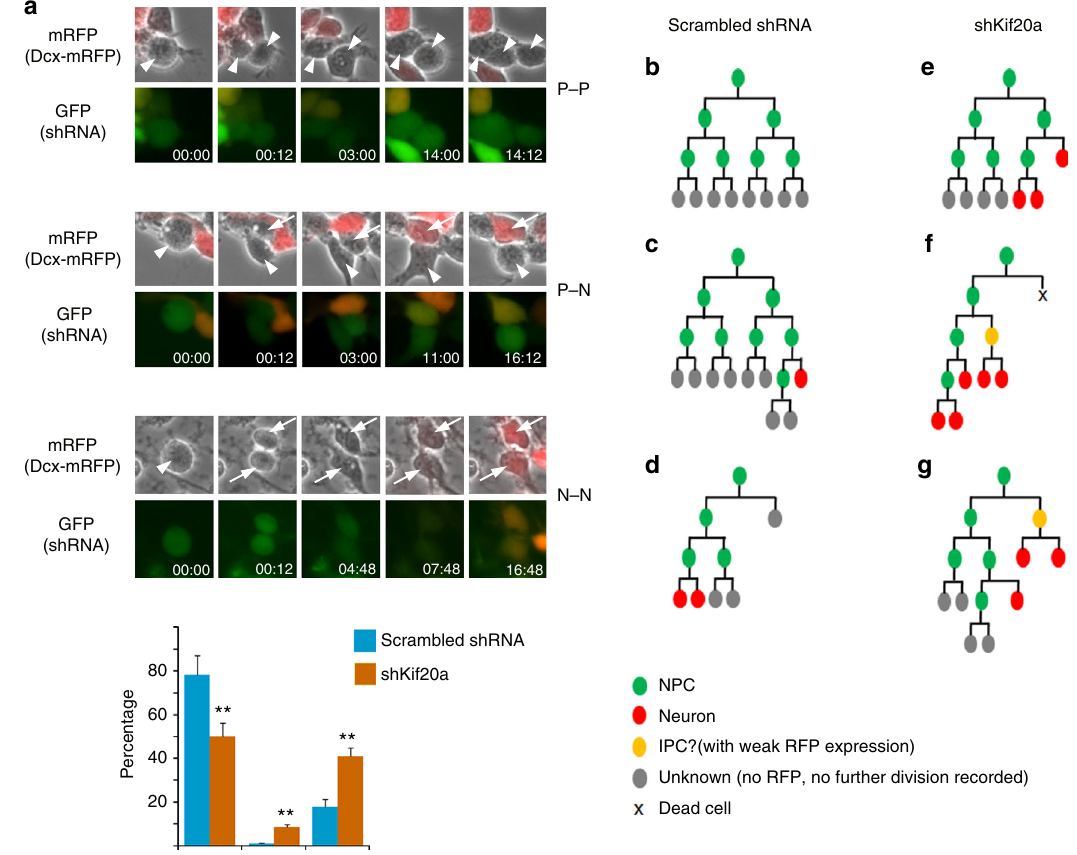
Fig. 3 KIF20A is important for the balance between proliferative and differentiative cell divisions. a Dissociated cells from the E13.5 cortices of the Dcx- mRFP transgenic reporter mice were infected with lentiviruses for expression of shKif20a or scrambled control shRNA. After culturing for 1 day post infection, shRNA-expressing (GFP positive) progenitor cells were imaged in live culture at intervals of 12 min for 48 – 72 h. Phase contrast and fl uorescent images at indicated time are shown. Appearance of RFP expression in some daughter cells re fl ected the emerging neuronal fate in these nascent cells. White arrowheads indicated mother and daughter progenitor cells. White arrows indicated daughter cells taking a neuronal fate. Progenitor – progenitor (P – P), progenitor – neuron (P – N), or terminal neuron – neuron (N – N) division modes were scored (in both shKif20a- and scrambled control shRNA- expressing progenitor cells, over 250 cell divisions were counted). Representative images of dividing cells shown here were expressing either the